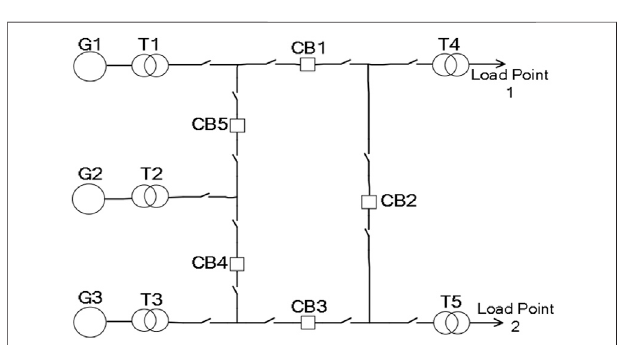
FIGURE 8 | Con fi guration of bus 07 in the